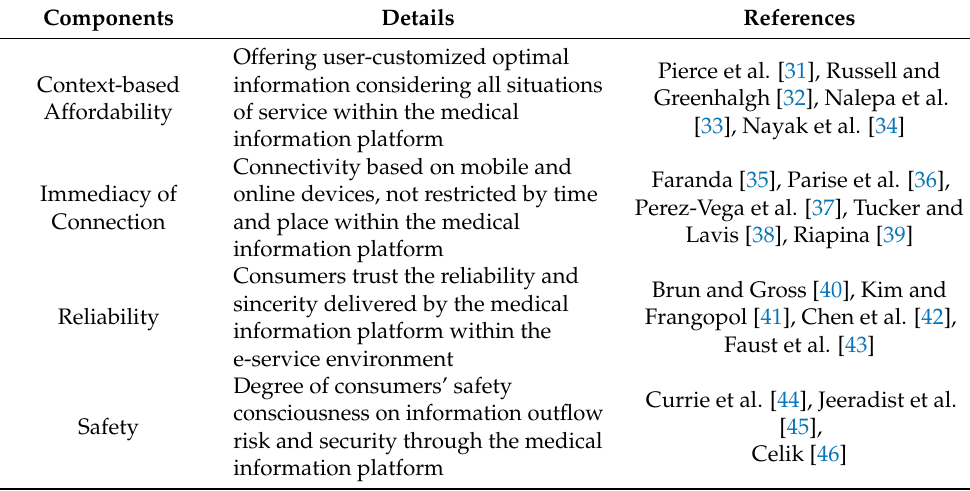
Table 1. Components of medical sector O2O platform service